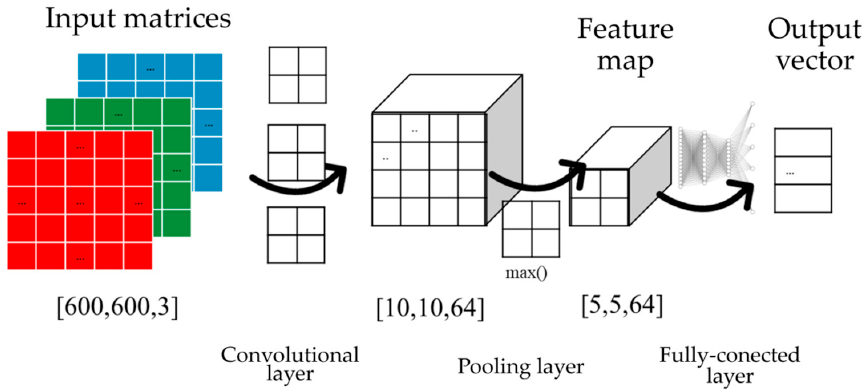
Figure 12. Idea of deep learning data processing.